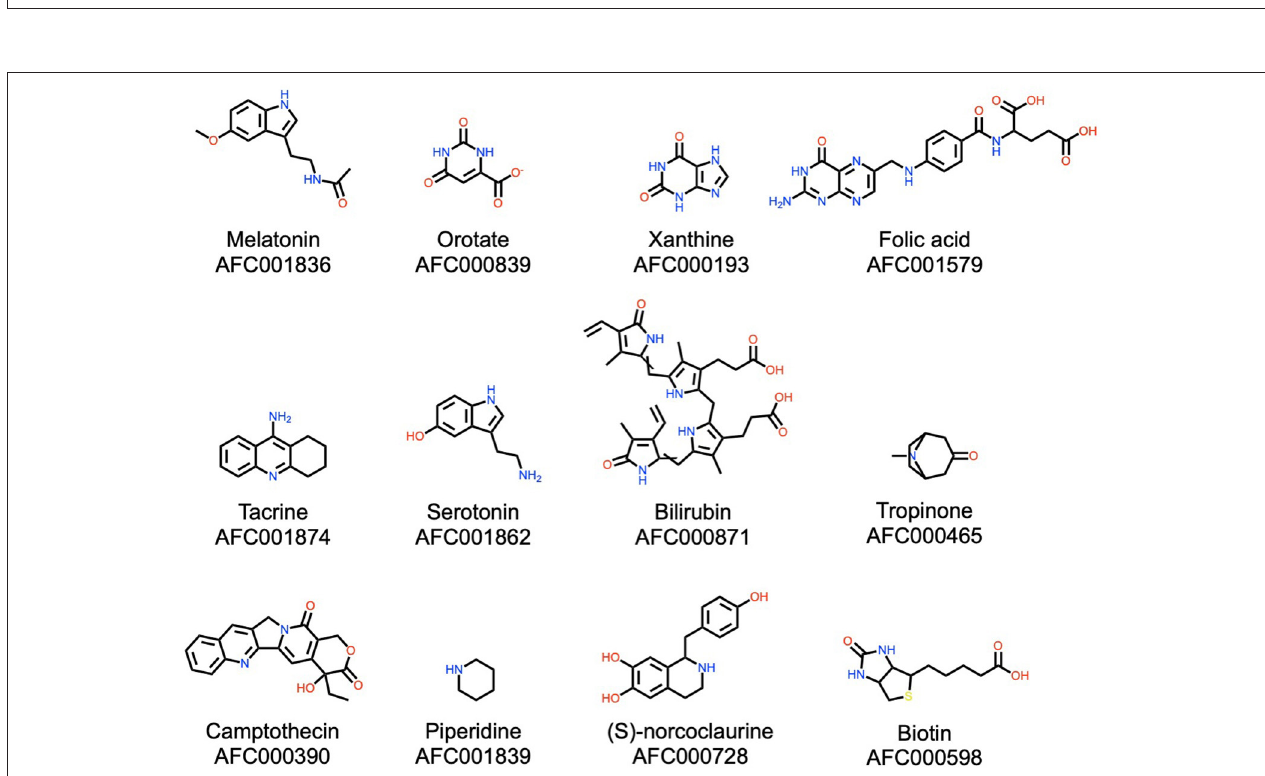
Frontiers in Nutrition |